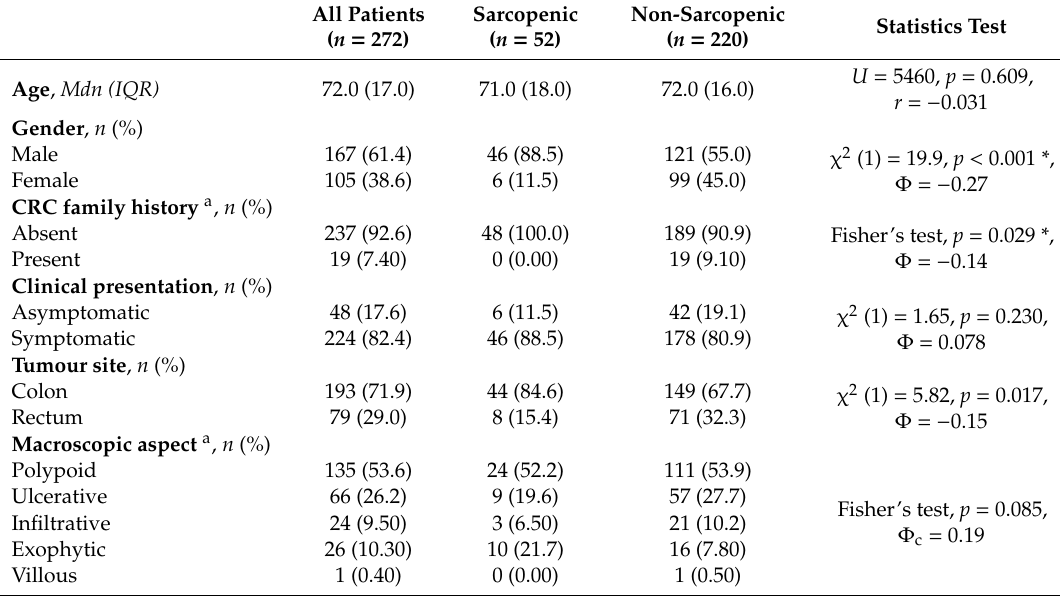
Table 1. Relationship between sarcopenia and clinicopathological